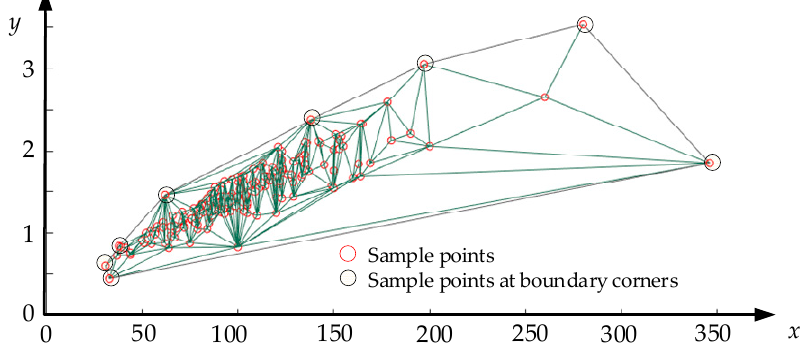
Figure 3. Using Delaunay triangulation to determine the area containing sample points.